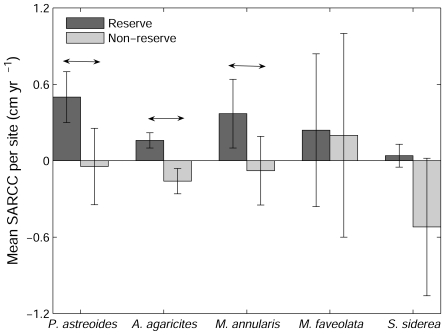
Size-adjusted rate of change of cover (SARCC) of dominant coral species at survey sites.Sites were inside and outside of the Exuma Cays Land and Sea Park, Bahamas. Error bars denote s.e.m. Horizontal arrow denotes significant differences (one-tailed t-test P<0.05).